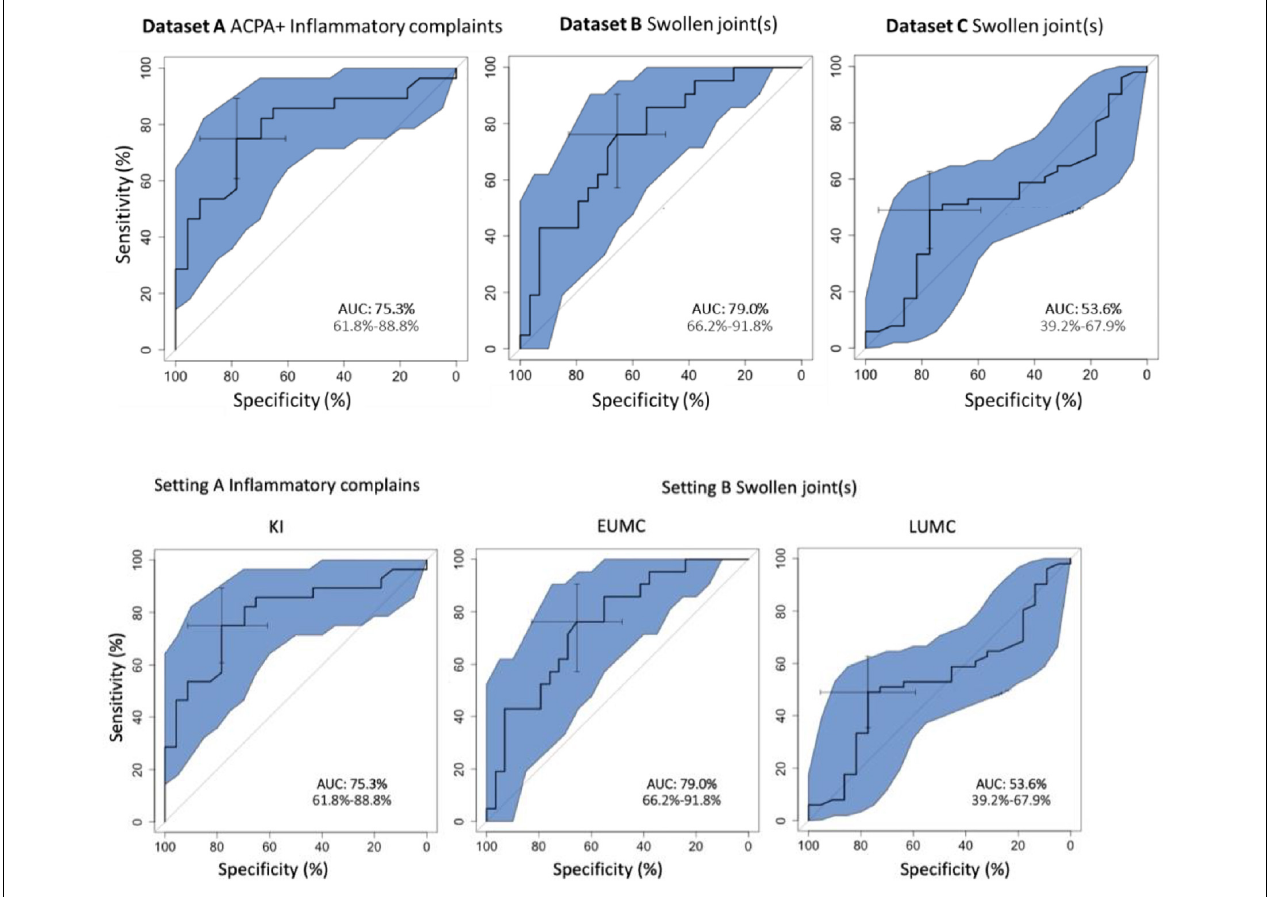
FIGURE 2 | (Area under) the receiver operating curve for the total score of Rheumatic? TABLE 3 | Performance of Rheumatic? in each cohorts in identifying immune-medicated rheumatic diseases using the predefined thresholds. Dataset A Dataset